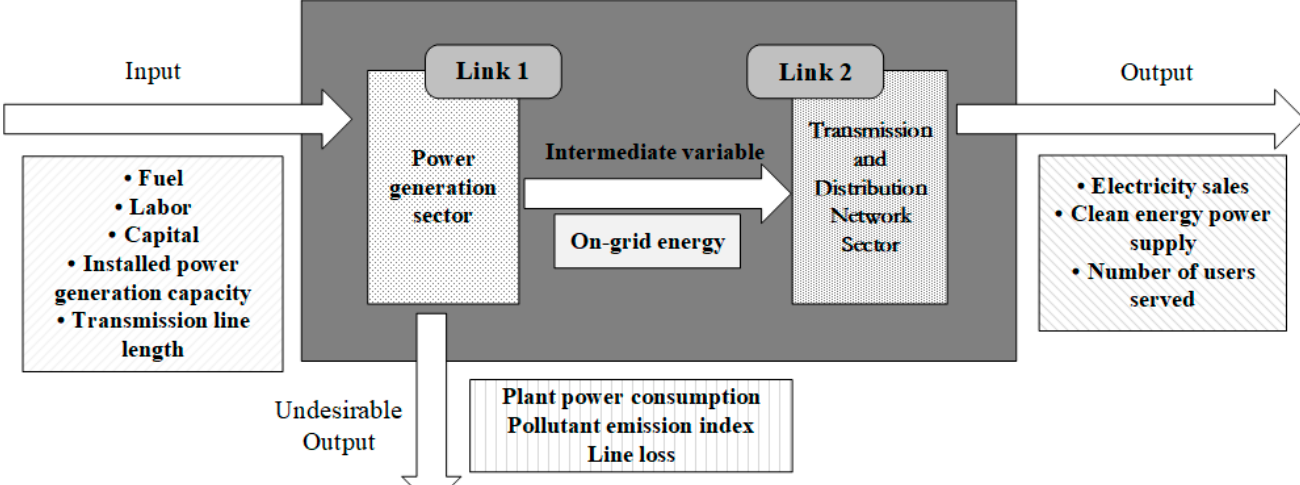
Figure 1. Power system production structure diagram.